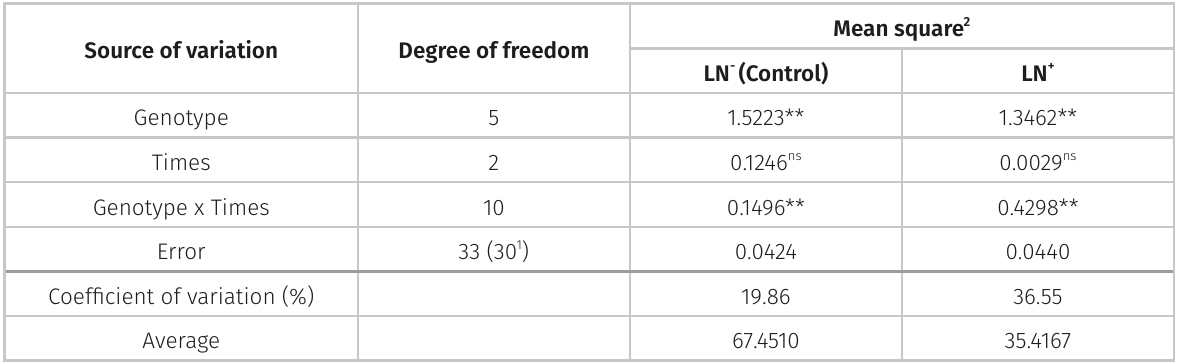
**significant at 1% probability by the F-test. ns not significant at 5% probability. 1 related to cryopreservation. 2 data transformed to arc sin